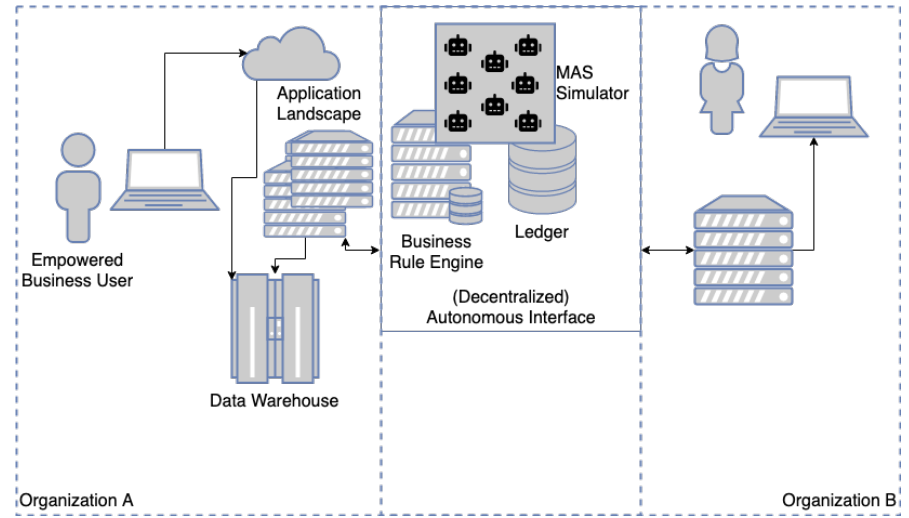
Figure 4. Integrated ABS at organizational